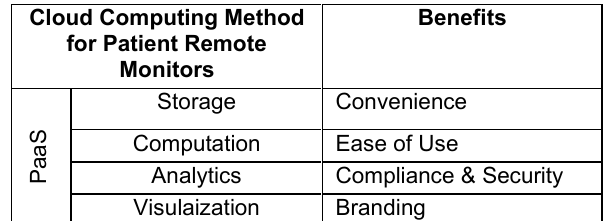
Table 3. Benefits of PaaS in Cloud-Based Patient Remote Monitoring